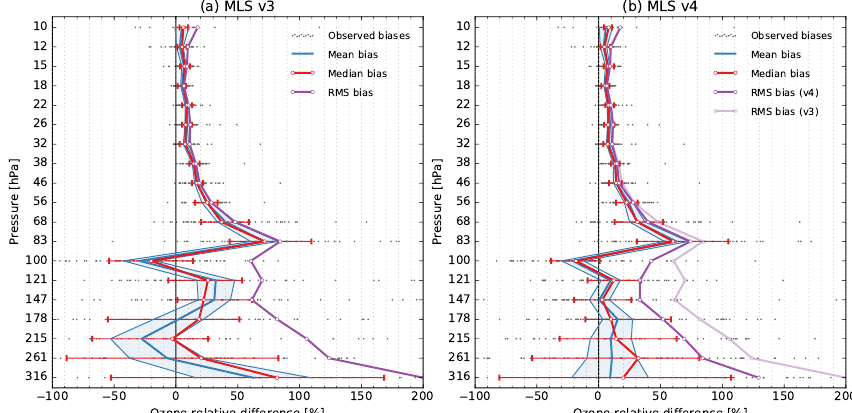
Figure 11. As in Fig. 4, but for relative biases between ECC and (a) MLS v3 and (b) MLS v4 profiles of ozone volume mixing ratio.